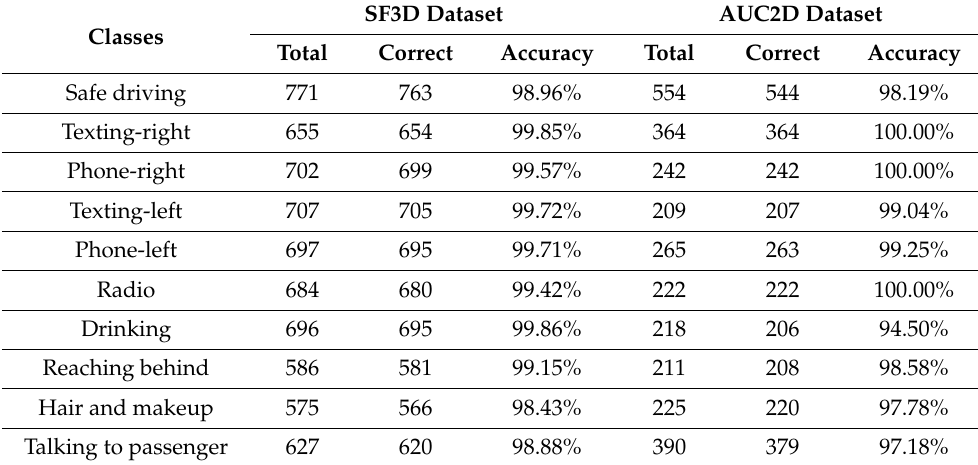
Table 3. Classification accuracy of each class.